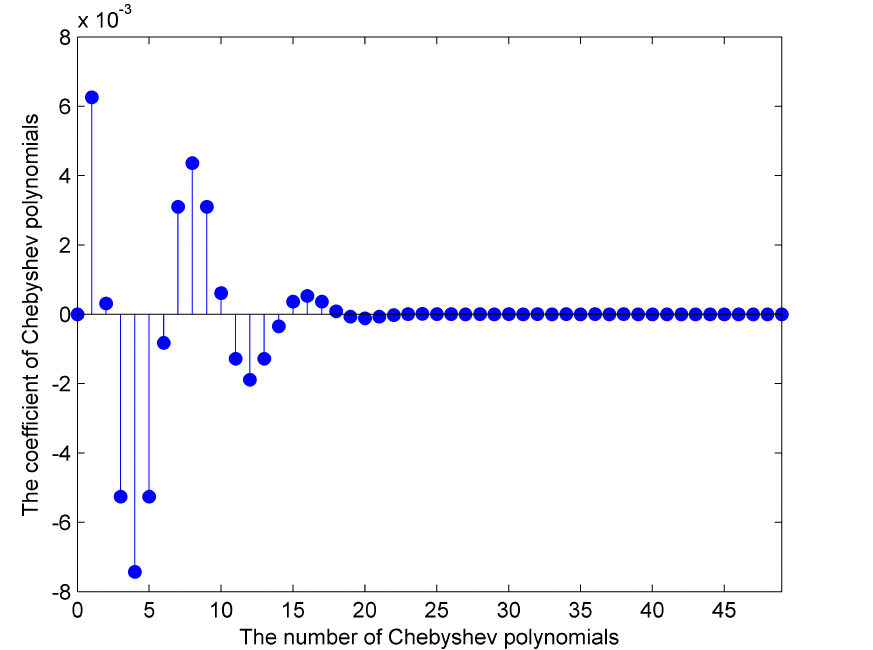
Figure 4. Diagram of the coefficients of Chebyshev polynomial